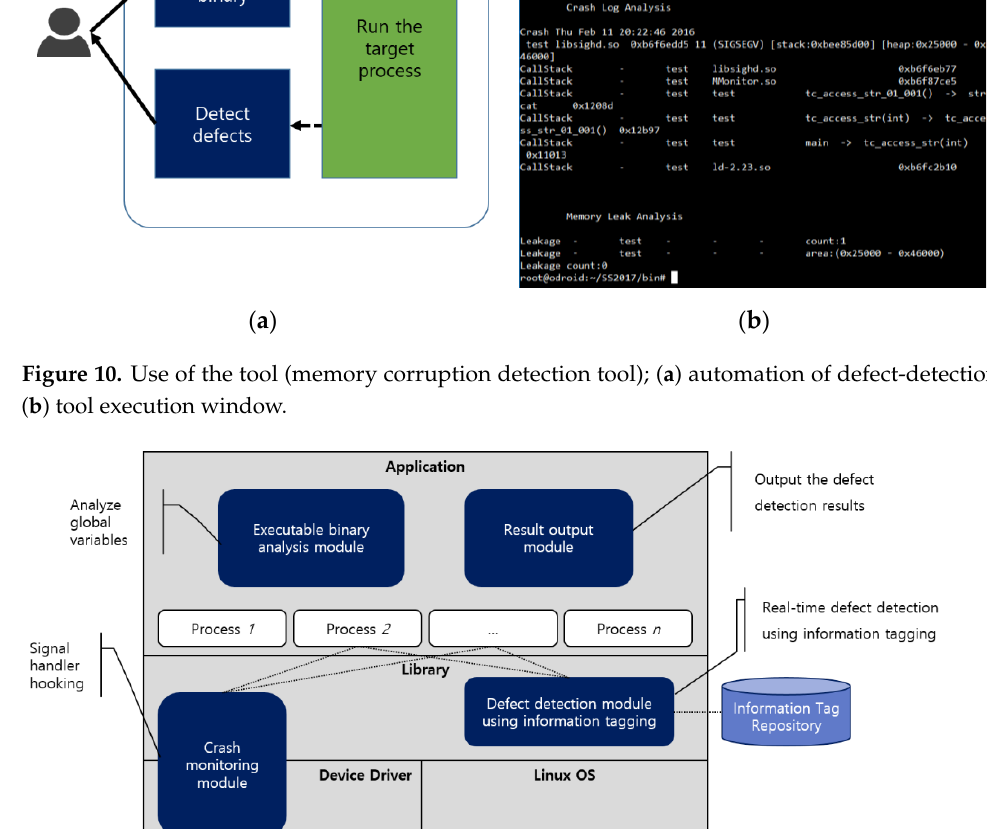
Figure 11. Conceptual diagram of hooking.